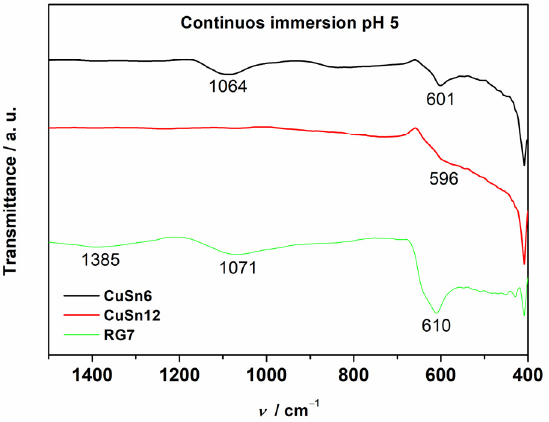
Figure 12. FTIR spectrum for continuous immersion of bronzes in acid rain at pH 5.